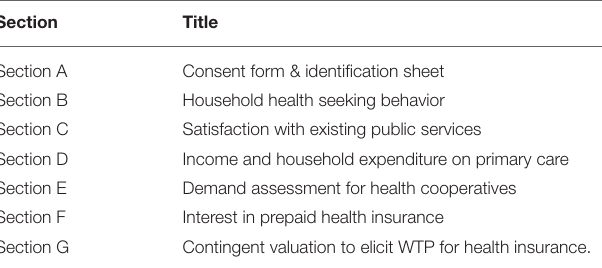
TABLE 1 | Components of the Demand